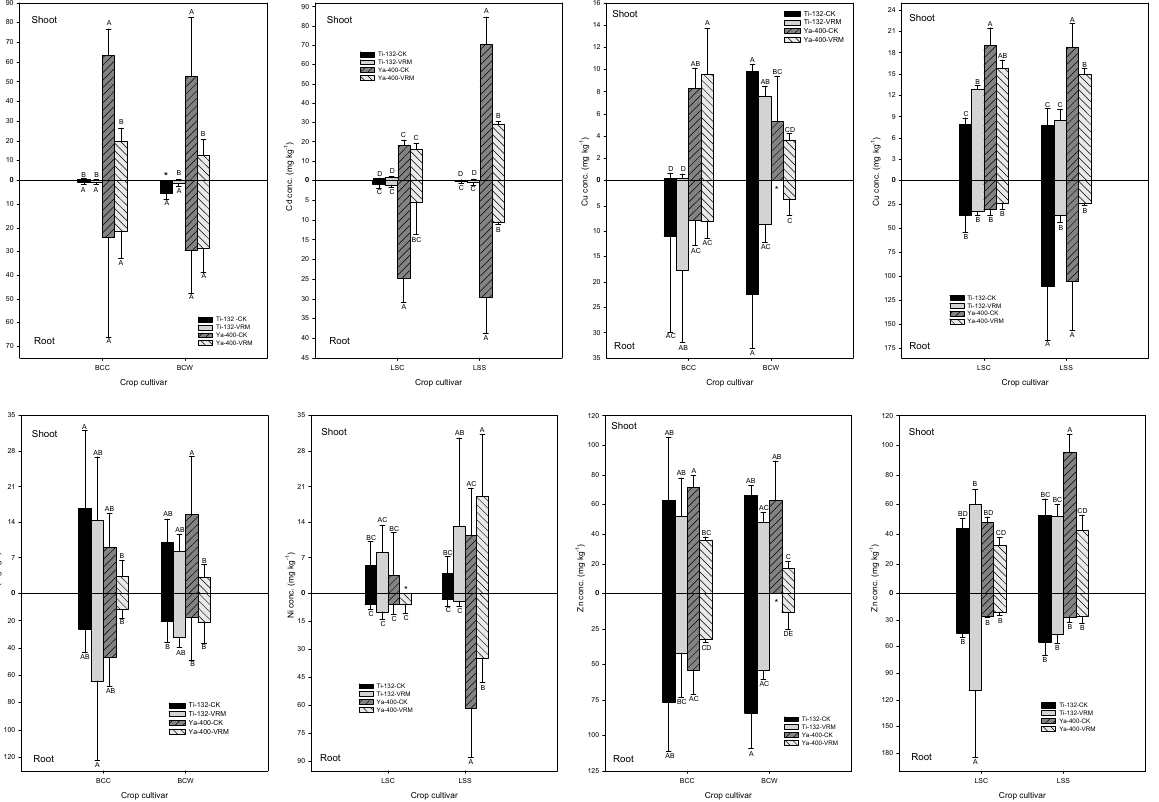
Figure 3. Effects of different treatments on the accumulation of Cd, Cu, Ni, and Zn in the roots and shoots of pak choi and lettuce. The meaning of each code is the same as Table 1. Different letters indicate significant differences across treatments, as determined by one-way ANOVA analysis (LSD test, p < 0.05, n = 3). * Not